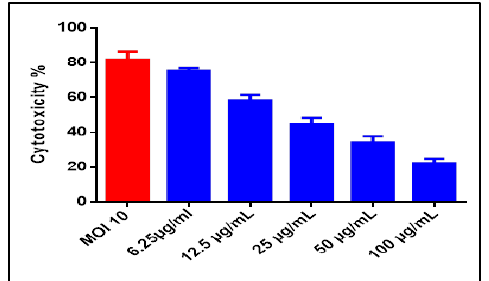
Figure1. Cytoprotecting chart; increasing the concentration of the tested sample (aqueous layer) reduce the cytotoxicity of measles virus on Vero cells using MOI of 10.